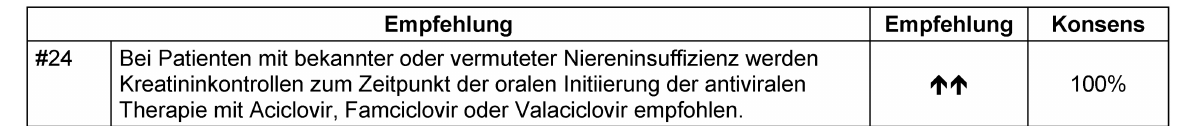
Tabelle 18: Therapie-Empfehlungen bei Zoster; Empfehlung